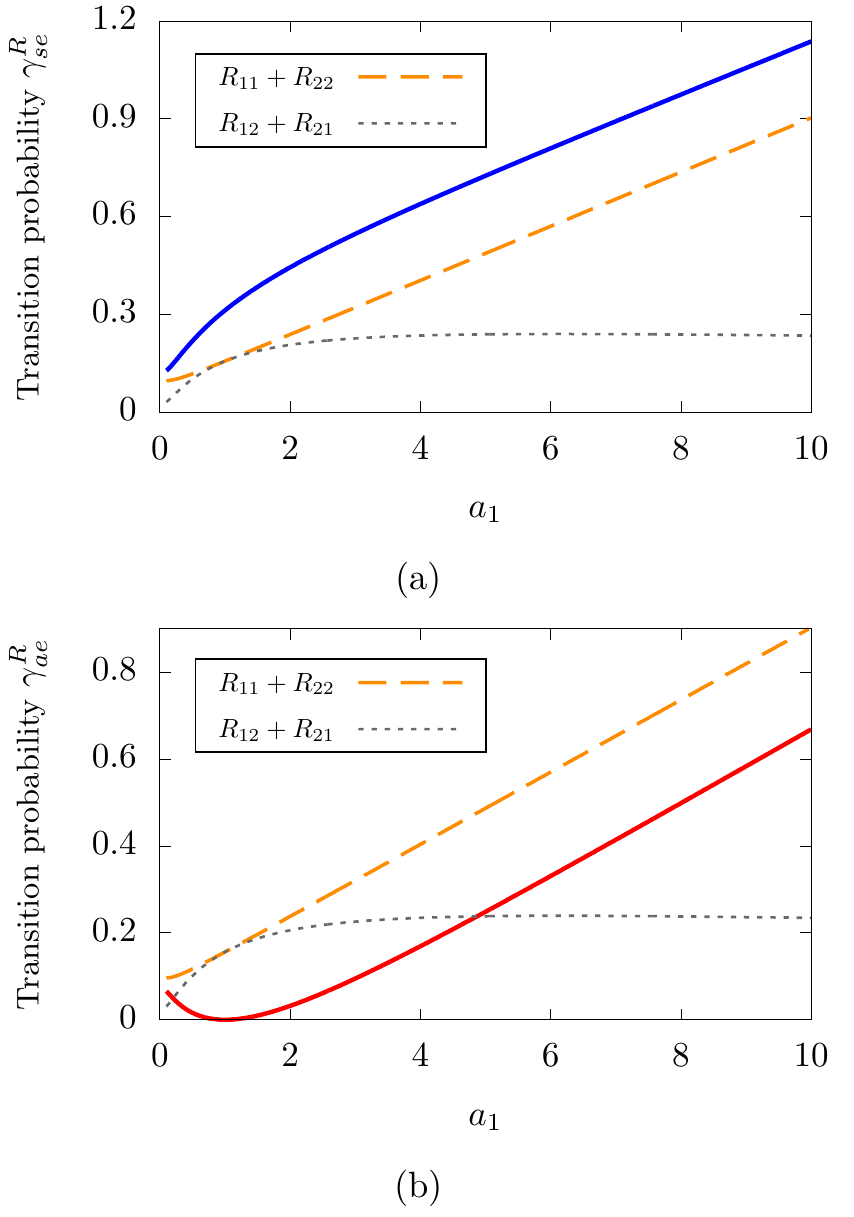
Figure 5 . (1 + 3) dimensions: (a) The transition probability from the symmetric state to the collective excited state denoted by the solid blue line. (b) The transition probability from the anti- symmetric state to the collective excited state denoted by the solid red line. In both of the cases the Rindler modes are considered. In both of the cases a 2 = 1 is kept fixed and a 1 is varied. The value of the other parameters are ∆ E = 0 . 1 , and β = 2 π